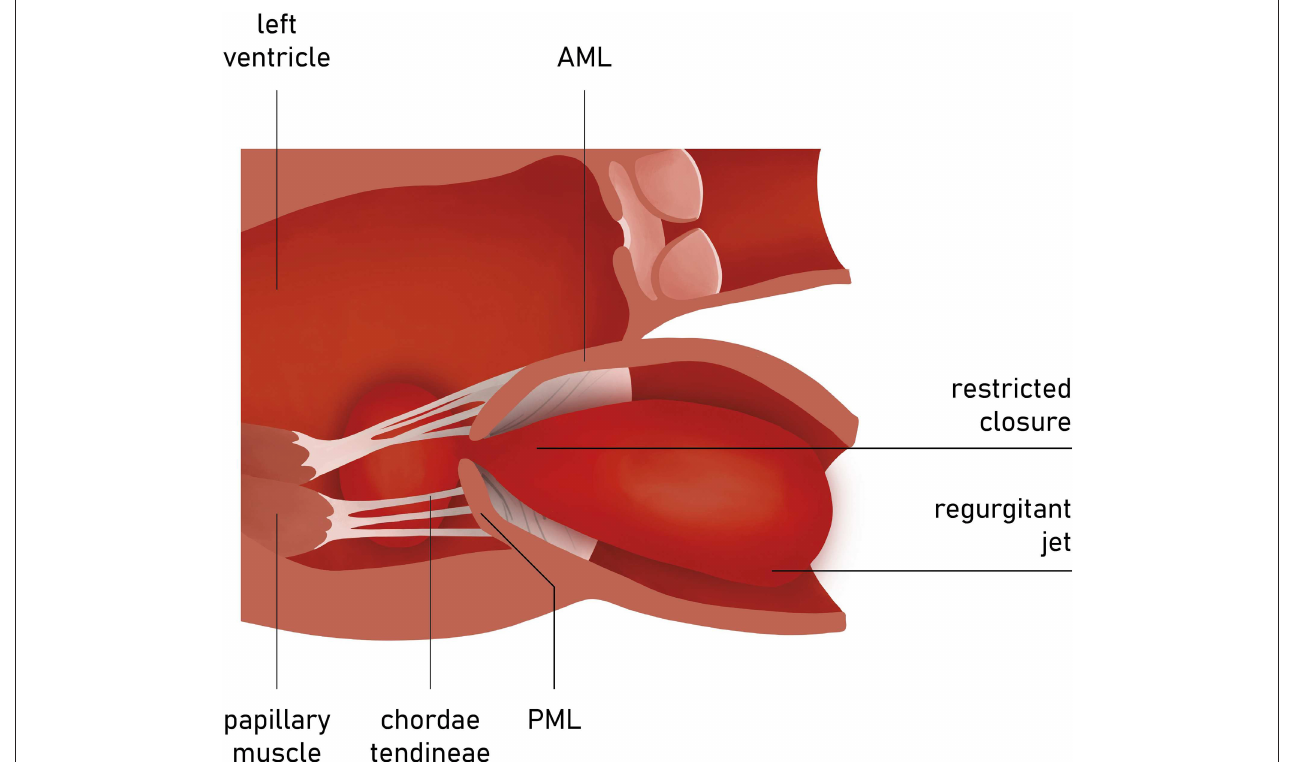
FIGURE 6 | Carpentier type I mitral regurgitation (depending from annular dilatation). Normal leaflet motion. Regurgitation jet directed centrally.